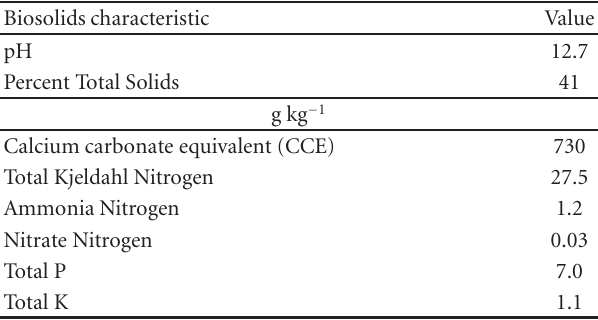
Table 1: Selected chemical properties of the biosolids (processed by the EnviroData Group, Lexington,